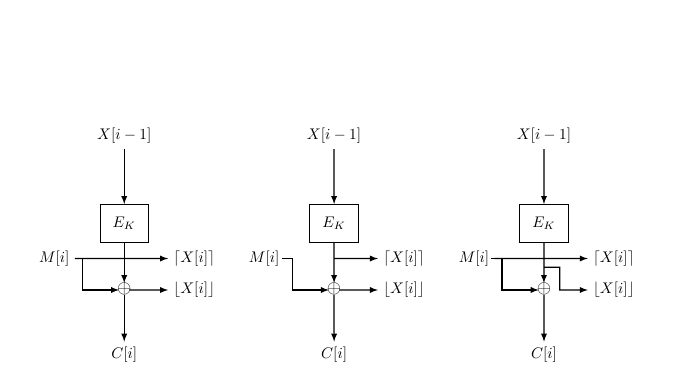
Figure 4: Types of Hybrid Feedback (from left to right): (PFB,CFB): d X [ i ] e